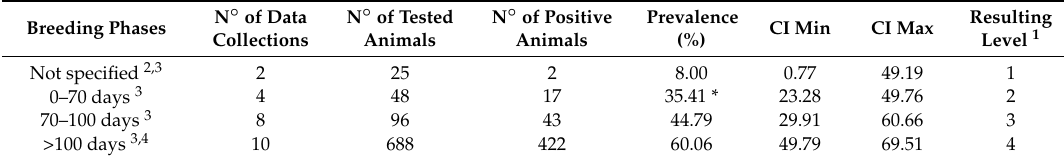
Table 4. Prevalence estimates of MRSA in turkeys, in different farming phases, as estimated by Generalized Estimating Equations on data from the literature